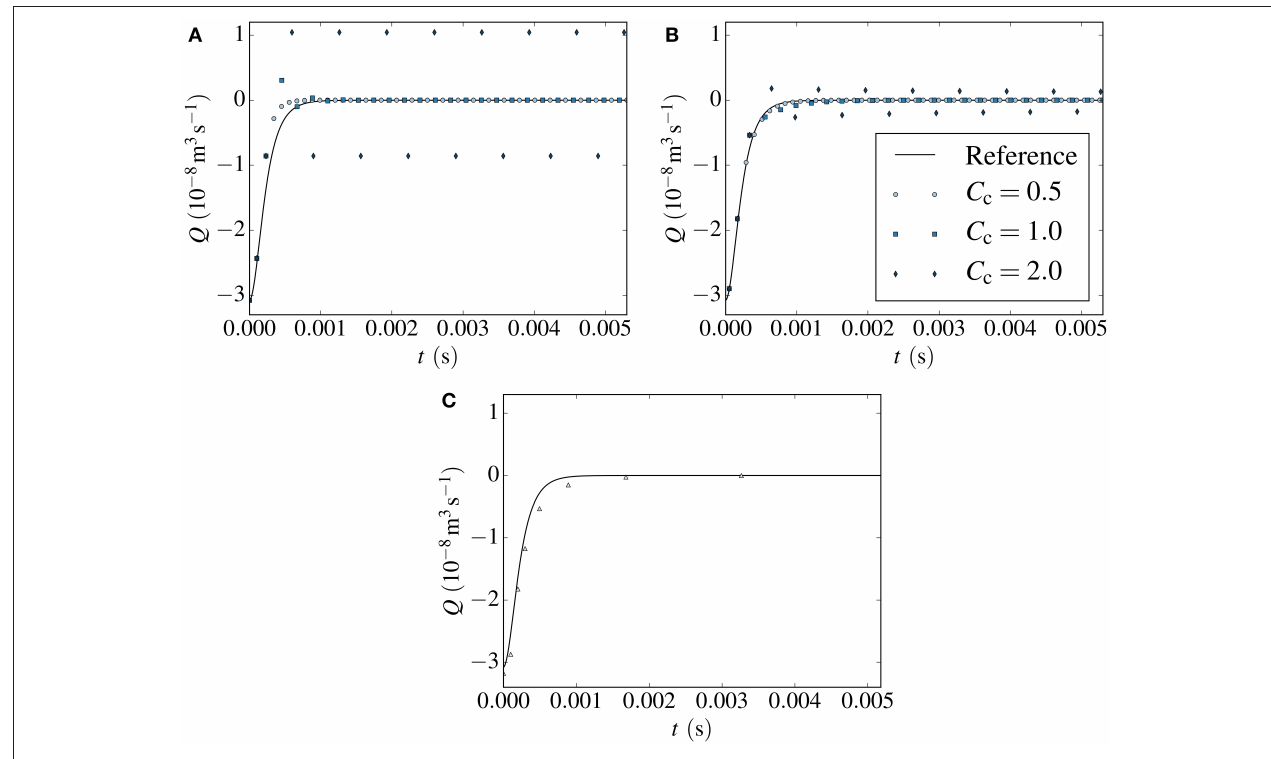
FIGURE 6 | Flow rate plotted against time in the link-in-series test case with 1 P = 0Pa. Results from the forward Euler method (A) and the midpoint method (B) are shown for different values of C c . Severe numerical instabilities arise when C c = 2.0. Results from the semi-implicit method are shown are shown in (C) . These are stable, even if the capillary time step criterion is not used. The solid black line represents a reference solution.